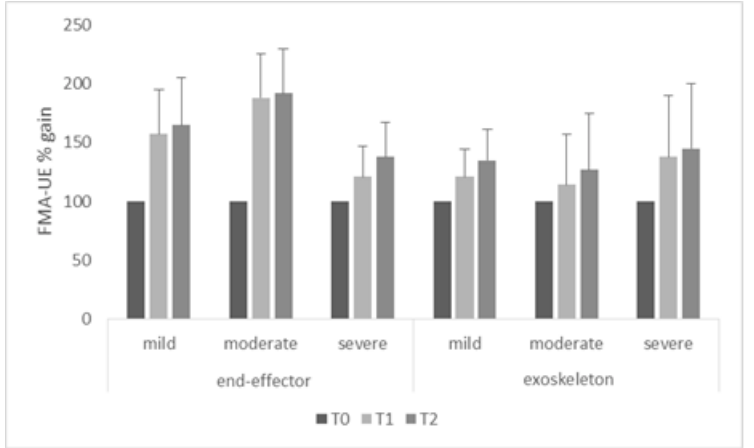
Figure 3. Post ‐ treatment Fugl ‐ Meyer Assessment for the upper extremity (FMA ‐ UE) gain (i.e., at T1 and T2 with respect to the level of impairment of the baseline (T0) FMA ‐ UE value, calculated as T1/T0 × 100 and T2/T0 × 100) in both groups and from all the patients. The vertical error bars refer to SD.